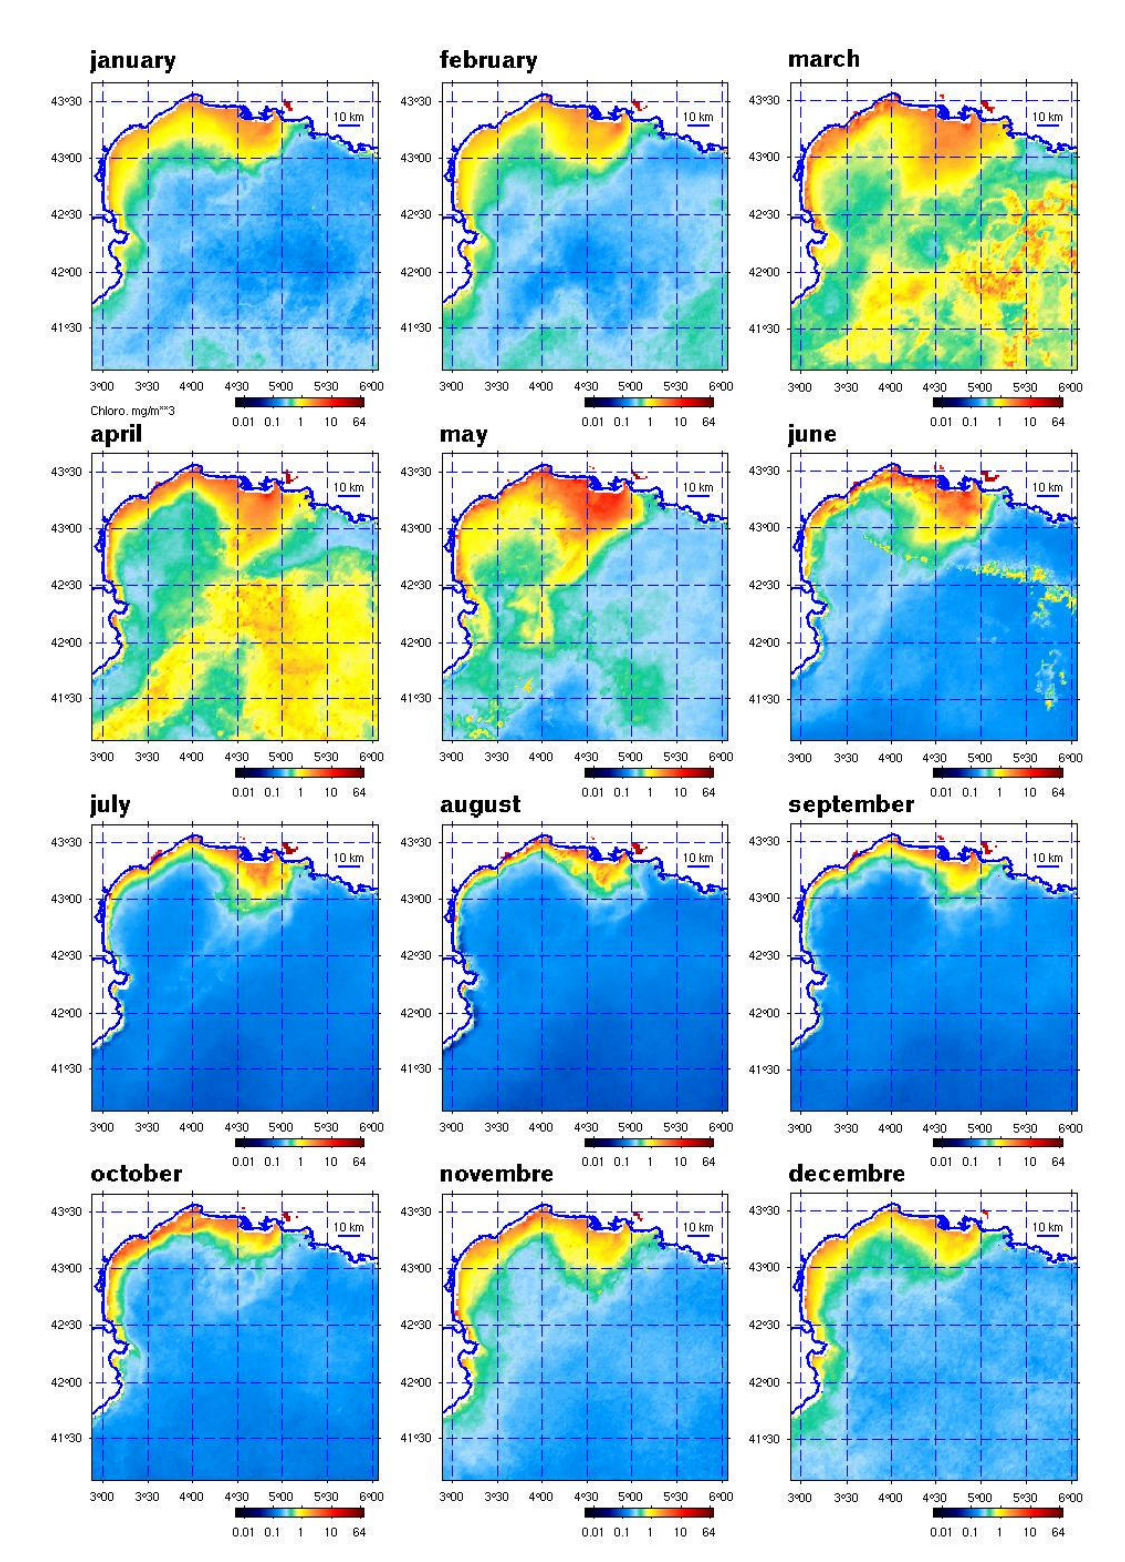
Figure 9. The mean monthly chlorophyll distribution in the GoL from SeaWiFS imagery for the period